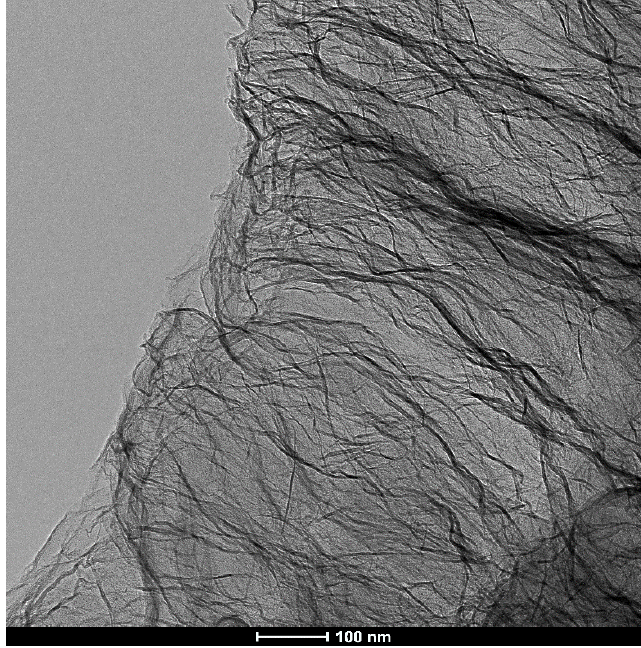
Figure 2. TEM (transmission electron microscopy ) image of graphene oxide (GO) flakes.